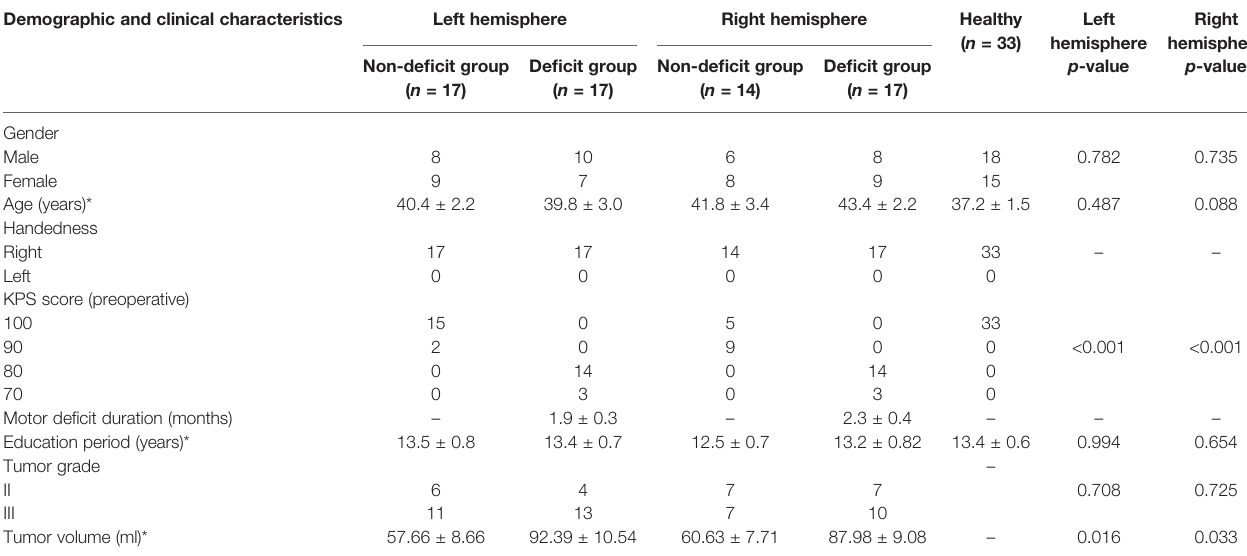
TABLE 1 | Demographic and clinical